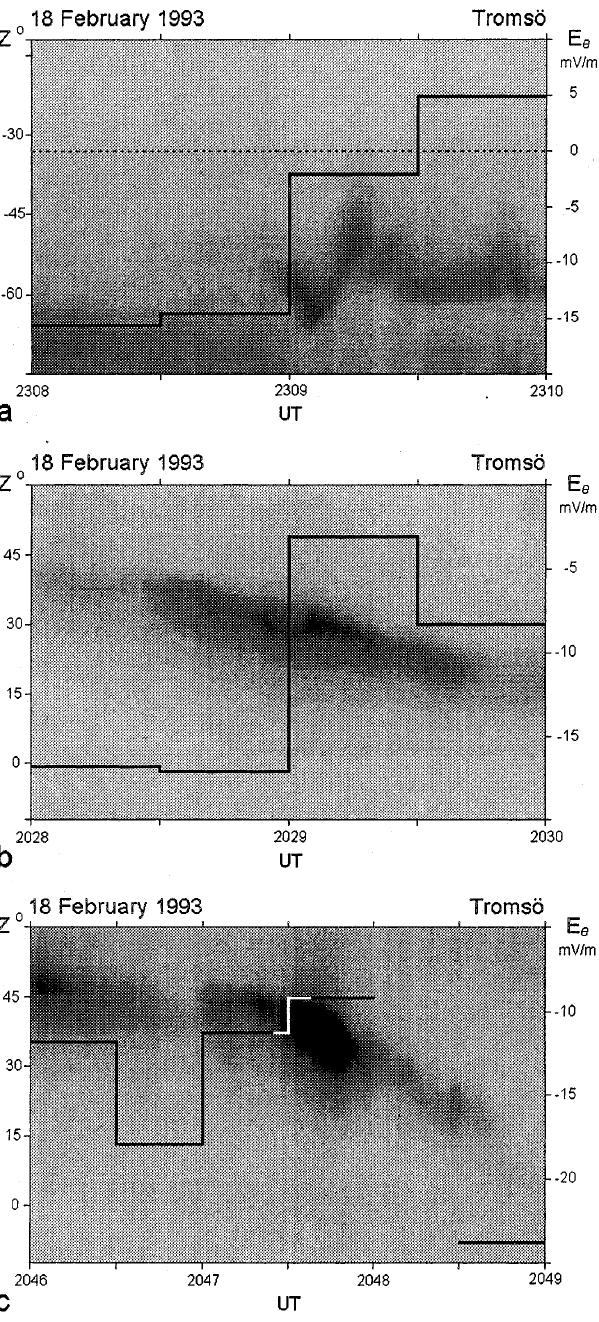
Fig. 3a–c. The grey-coded keograms showing dynamics of the auroras along Z-profile and variations of 30 s averaged values of the azimuthal component of ionospheric electric field ( black step-like traces ). Z is the zenith angle, E is azimuthal component of the e ionospheric electric field (positive east)